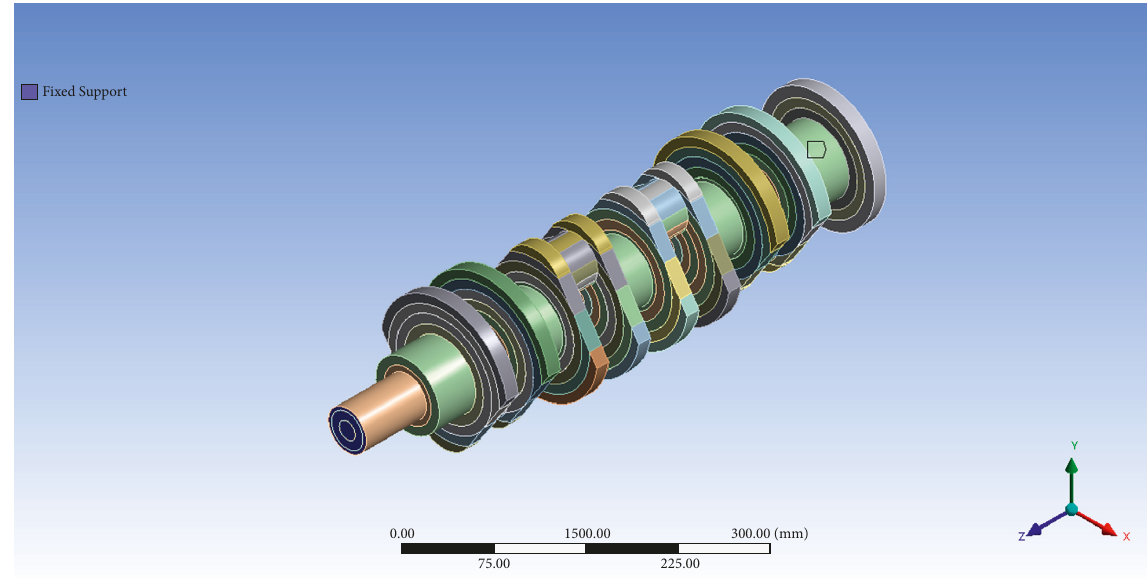
Figure 4: Engine shaft (FGM).